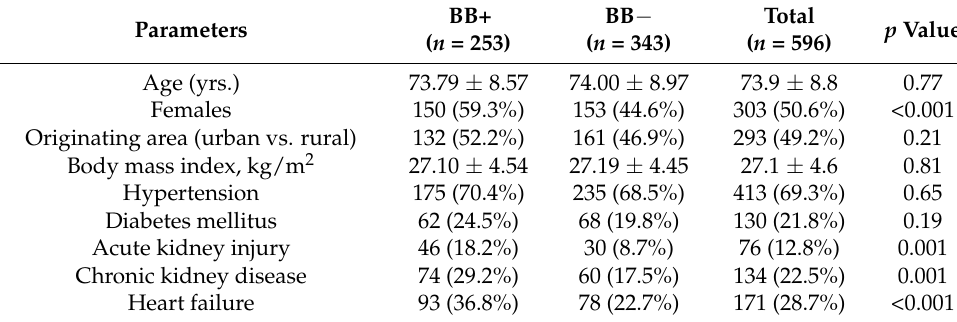
Table 1. Demographics and comorbidities.